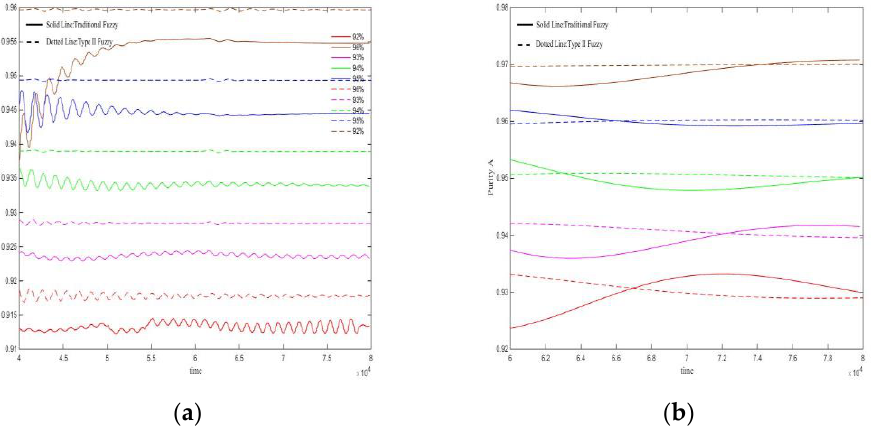
Figure 14. Under the change of the adsorbent parameter H A = 0.01 → 0.03. ( a ) Extraction outlet (material B); ( b ) raffinate outlet (material A).